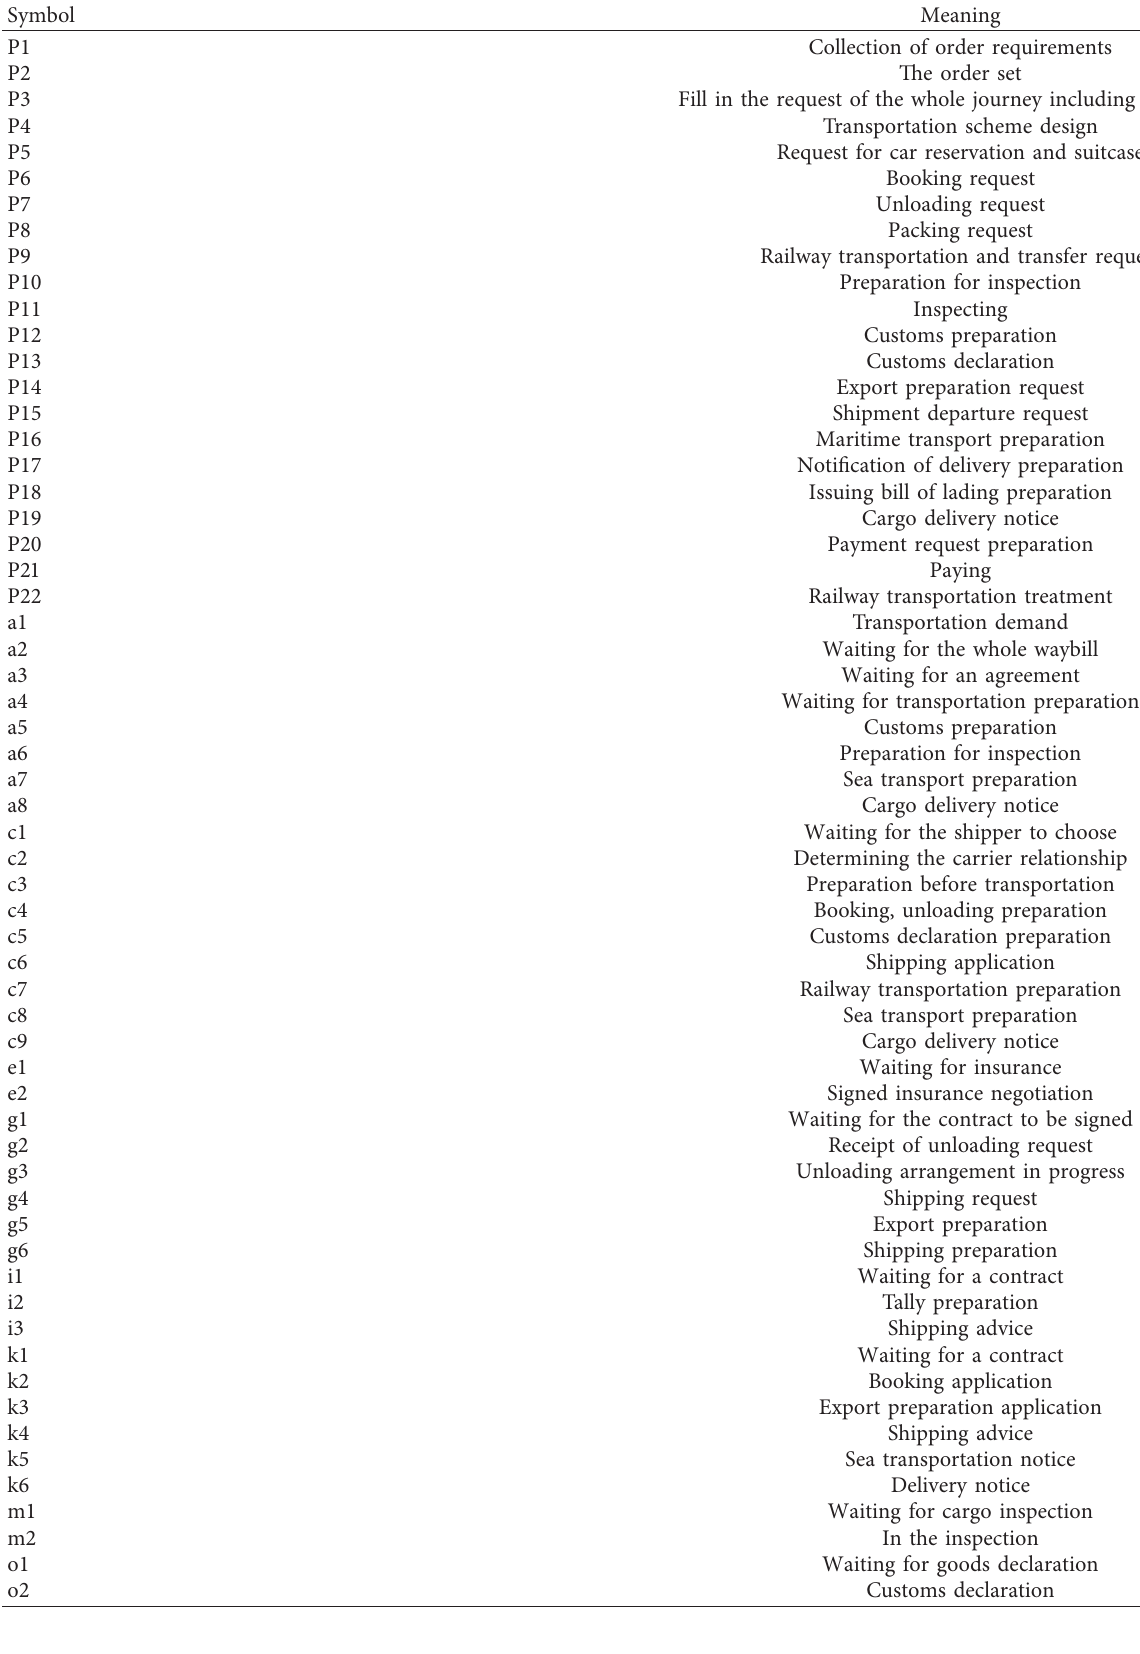
Table 5: FPMS OOPN model symbol meaning of container export information flow.